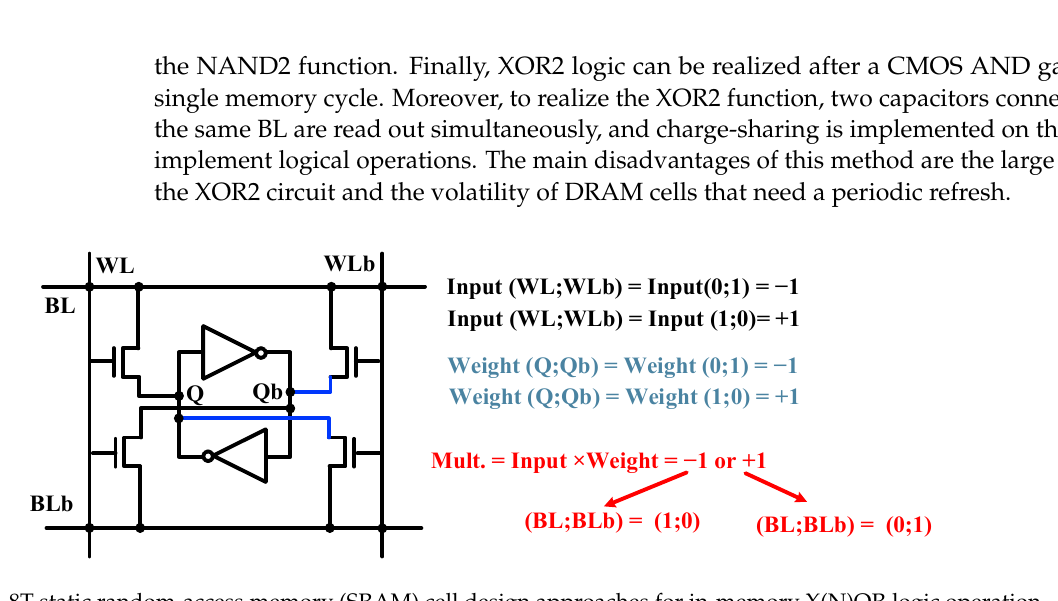
Figure 1. 8T static random-access memory (SRAM) cell design approaches for in-memory X(N)OR logic operation.